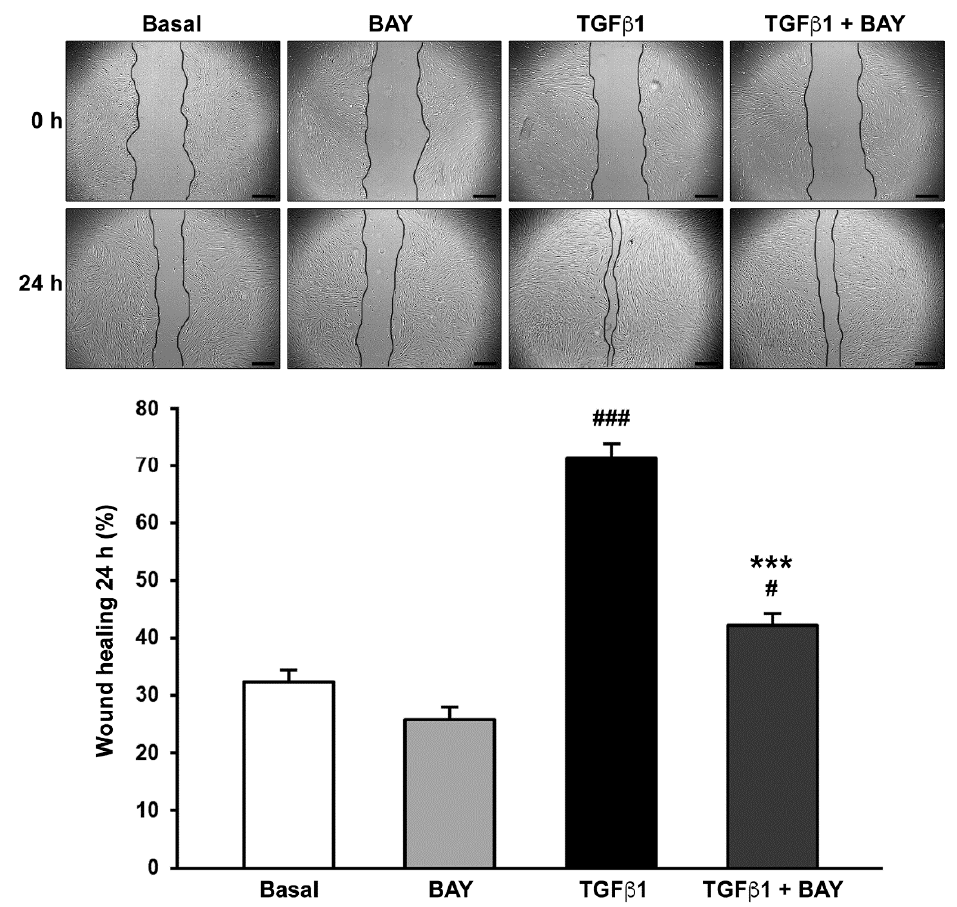
Figure 3. Soluble guanylate cyclase stimulation with BAY 41-2272 significantly reduces TGF β 1-induced ability of human keratocytes to restore the monolayer integrity after scratching. Wound healing capacity was evaluated in keratocytes at basal condition and after treatment with recombinant human TGF β 1, TGF β 1 and BAY 41-2272, or BAY 41-2272 alone. Representative phase-contrast photomicrographs of the wounded area at 0 and 24 h are shown for each experimental condition (original magnification ×10); wound margins are outlined in black. Scale bar: 400 μ m. Bars represent the mean ± SEM of triplicate determinations of the percentage of wound healing after 24 h ( n = 5 cell lines). # p < 0.05, ### p < 0.001 vs. basal condition, *** p < 0.001 vs. TGF β 1 alone (Tukey’s test). SEM, standard error of the mean; TGF β 1, transforming growth factor β 1.